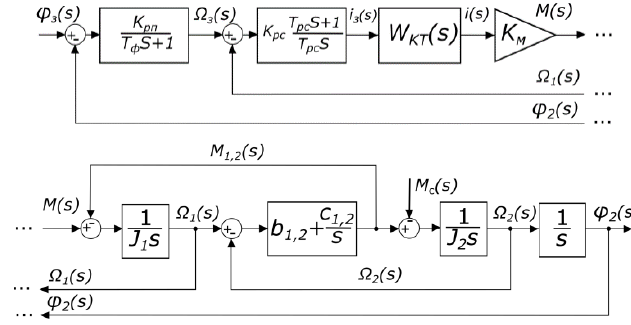
Fig. 10 . Block diagram of a feed drive with a two-mass hardware closed by position, speed and